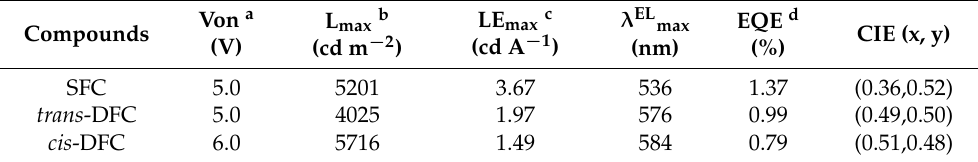
Table 2. EL data of SFC, trans -DFC, and cis